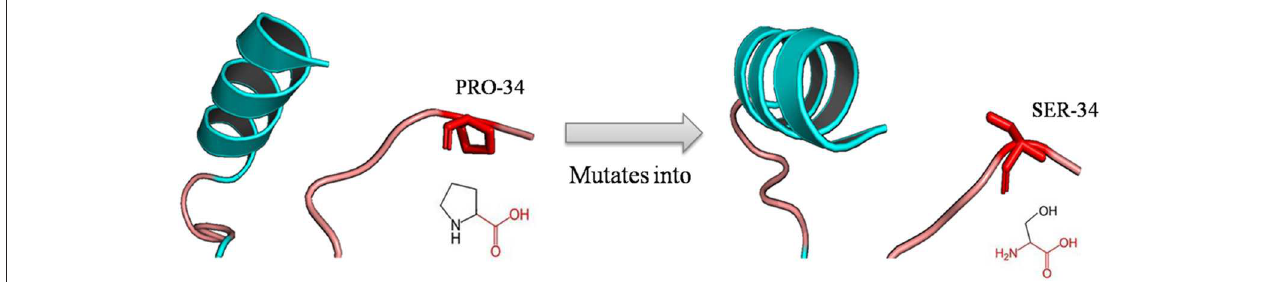
FIGURE 3 | Schematic structures of the native (left) and mutant (right) amino acid. The backbone colored red and the same for each amino acid, and side chain unique for each amino acid is colored black; the mutation of proline into serine at position 34 for rs1065852.